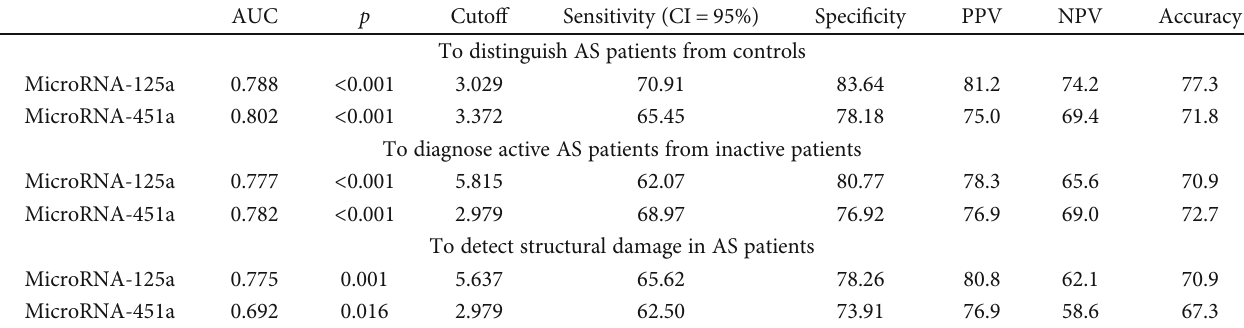
Table 3: ROC curve analysis for microRNA-125a and microRNA-451a to diagnose structural damage in AS patients.